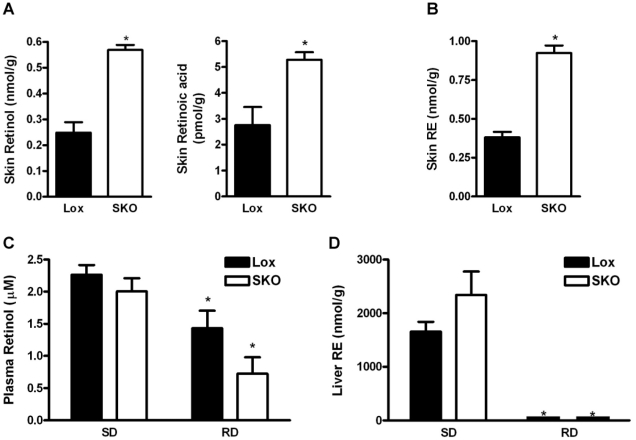
Altered retinoid homeostasis in SKO mice.A) Skin retinol and retinoic acid, as well as B) skin retinyl esters (RE) in male mice fed the standard diet (SD). * = p<0.05 for lox vs. SKO, n = 7–8 per group. C) Plasma retinol levels and D) liver RE levels in male mice fed either SD (n = 7–8 per group) or a retinoid-deficient (RD) diet (n = 6 per group). Data represent mean ± SEM. # = p<0.05 for SD vs. RD within same genotype.